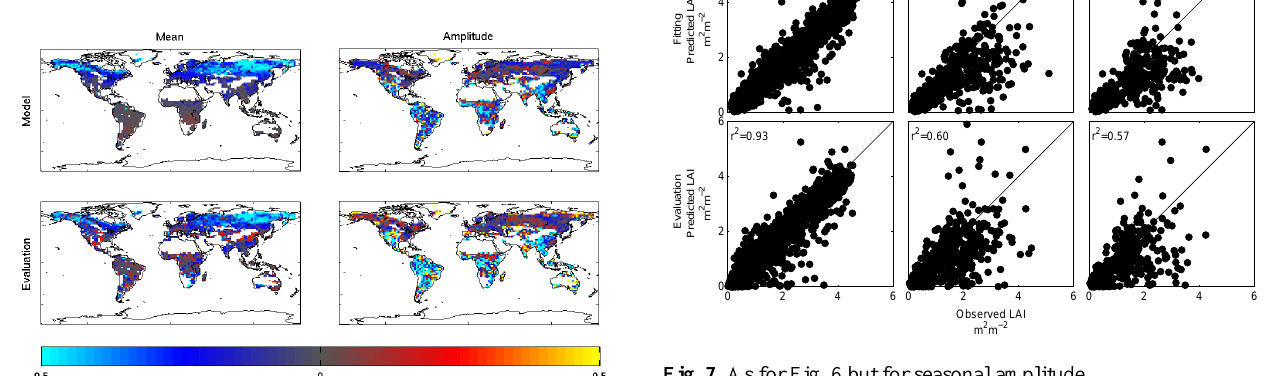
Fig. 4. Root mean squared error (RMSE) of predicted LAI nor- malised by mean LAI for (a) the study period (2000–2005) and (b) the evaluation period (2006) .